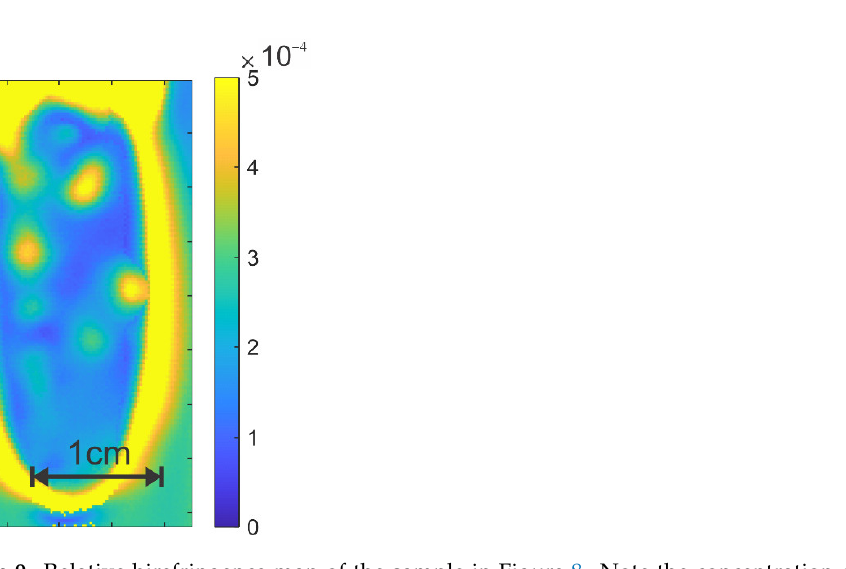
Figure 10. ( a ) Closeup reference picture of the two termite workers in the Dominican amber matrix. ( b ) Terahertz image generated from the natural log of the mean terahertz transmitted amplitude in the 0.5–2 THz band.